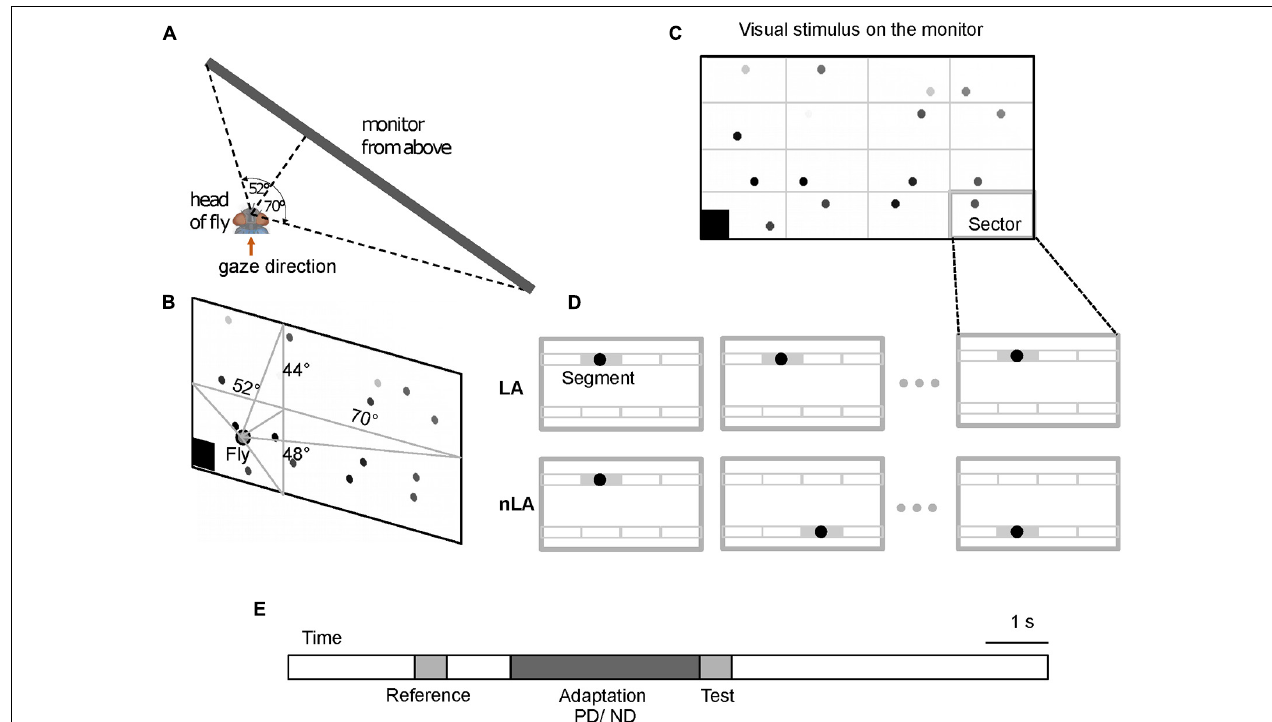
FIGURE 1 | Schematic of visual stimulation paradigm. (A,B) Schematic of the monitor screen as seen from the perspective of the fly from above (A) and from behind (B) . The monitor is placed in front of the fly’s right eye. The perpendicular from the monitor hitting the fly’s right eye at its smallest distance to the monitor divides the monitor screen into four parts. The angles indicate the angle at which the left and right as well as the upper and lower edges of the screen are seen from the fly’s perspective. 16 horizontally moving dots constitute the visual stimulus. (C) One frame of a visual stimulus as an example. The stimulus consisted of a white background and 16 dots with different gray levels from white to black. The black square at the bottom left corner of the screen was a trigger signal for data acquisition. The gray grid that divides the screen into 16 identical sectors was invisible to the fly and is shown here just to illustrate the sector of the screen in which each dot was allowed to move. (D) Schematic of stimulus conditions with local motion adaptation (LA) and without local motion adaptation (nLA) demonstrated for one sector shown at consecutive instants of time as an example. Thin gray lines within the sector outline eight segments that a dot possibly traverses during the stimulation period. The gray segment is the active segment the dot is traversing at the corresponding time indicated by the time axis. Under the LA condition the dot repeatedly moves across the same segment again and again for the entire stimulation period to evoke local motion adaptation, while under the nLA condition the dot is repeatedly relocated to move in a different segment and, thus, to avoid eliciting local motion adaptation. (E) Adaptation protocol showing the time sequence of the reference, adaptation, and test stimuli. During adaptation, the dots moved in either the preferred direction (PD, left to right on the screen) or the anti-preferred direction (ND, right to left on the screen) of the right HSE-cell (see Materials and Methods for